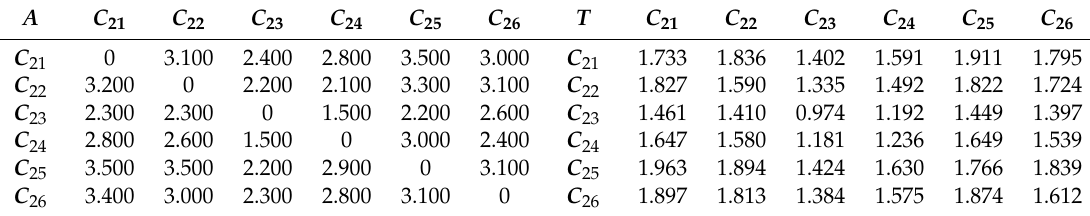
Table 3. The Average-direct influence relation matrix and total influence relation matrix of criteria in D 2 .